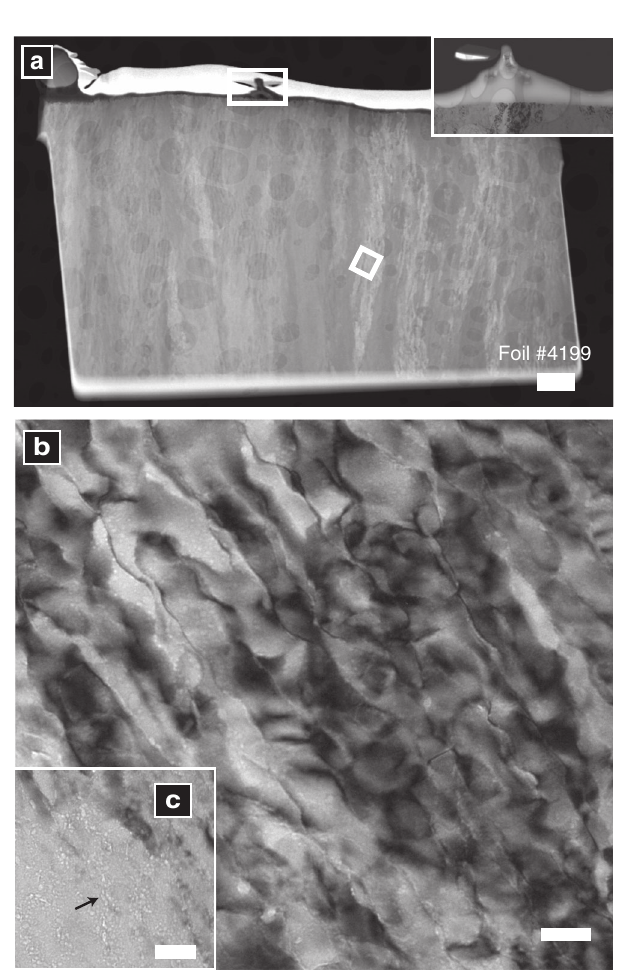
Fig. 2 Microstructure of O. universa shells. a High angle annular dark fi eld (HAADF) image shows the fi brous texture of the chamber and the base of a spine (white rectangle and enlarged in the inset). Note the organic membrane that covers the spine foundation in the inset. The circular features in the sample image are caused by the underlying carbon sample holder. b Bright- fi eld image of the particulate fi bres that comprise the chamber wall. c area in foil #4233 showing pores (arrow). Scale bars are 1 µ m ( a ), 50nm ( b ) 50nm ( c ). Analyses were carried out during session